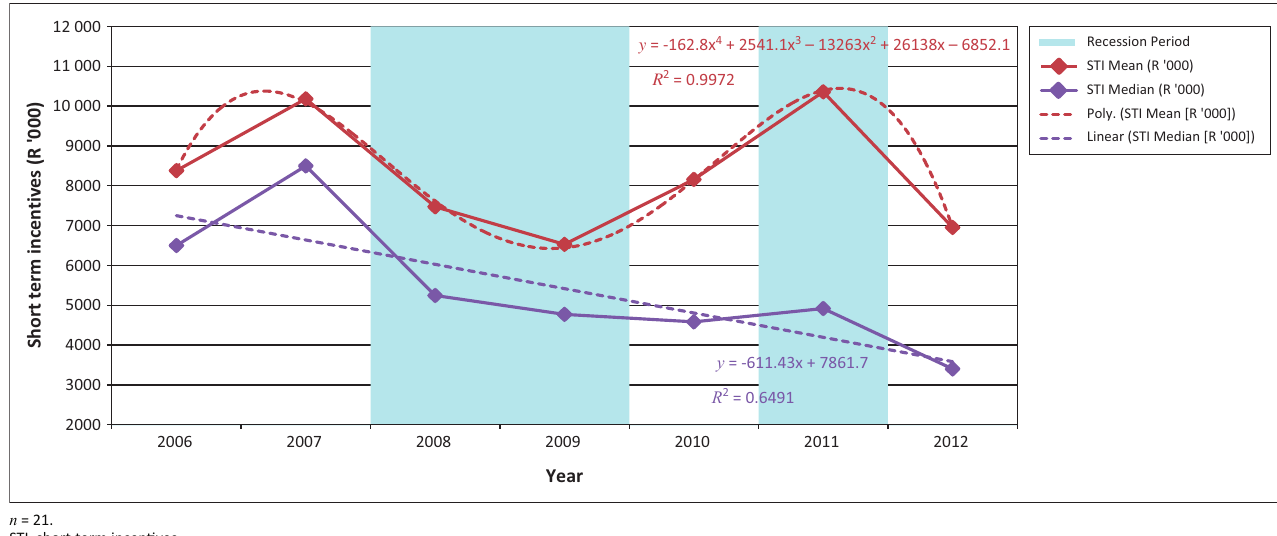
n = 21. STI, short-term incentives. FIGURE 2: Graphical representation of the descriptive statistics for CEO short-term incentives.